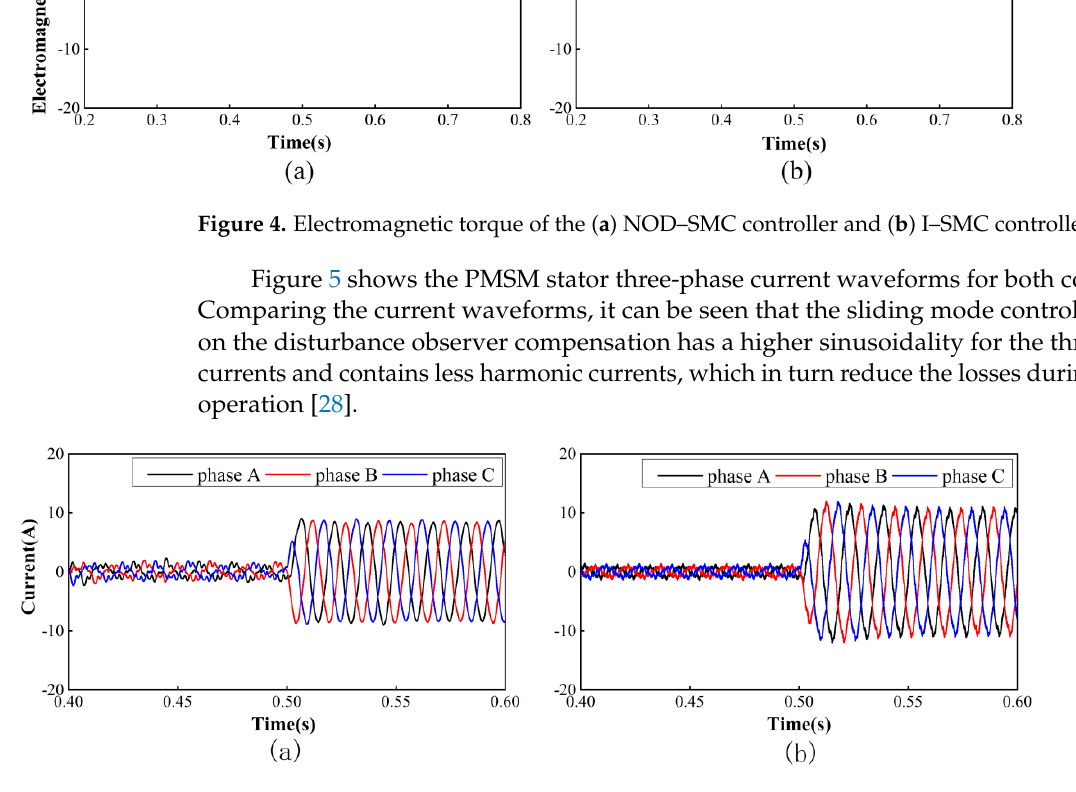
Figure 5. PMSM stator three-phase current waveforms of the ( a ) NOD–SMC controller and ( b ) I– SMC controller.